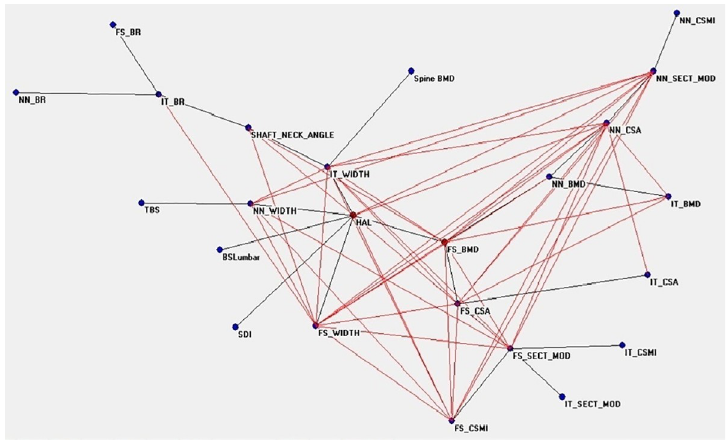
Fig 1. Semantic map showing the relations between the investigated anagraphic, anthropometric, densitometric, biochemical and clinical parameters in the whole population before treatment.